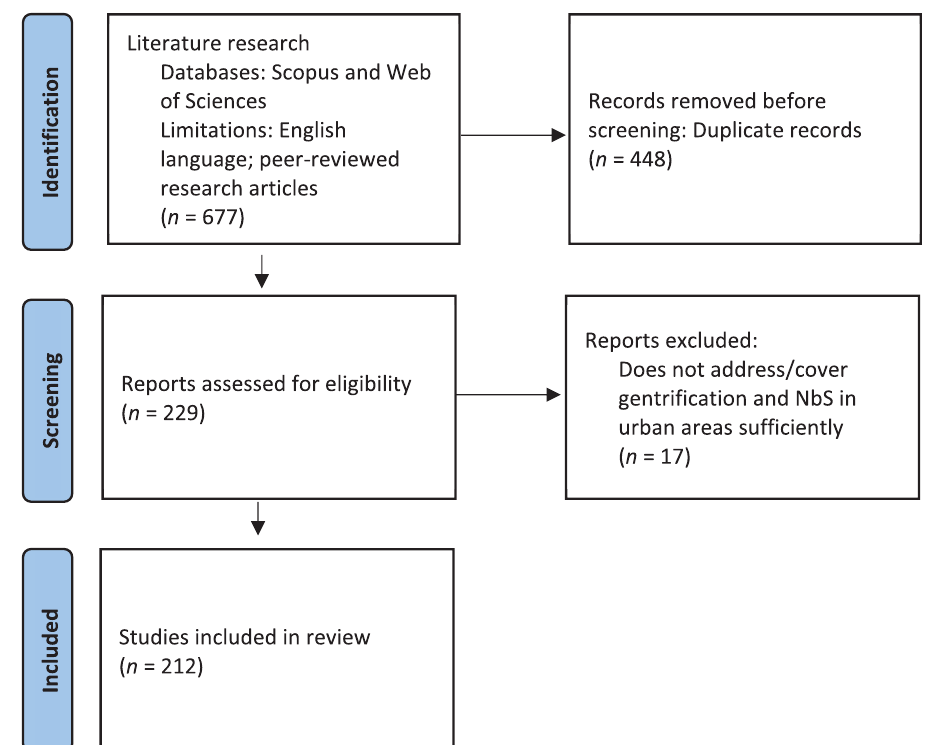
Figure 1. Flow chart of review process based on the PRISMA format. number of articles for each search string can be found in Table 1.